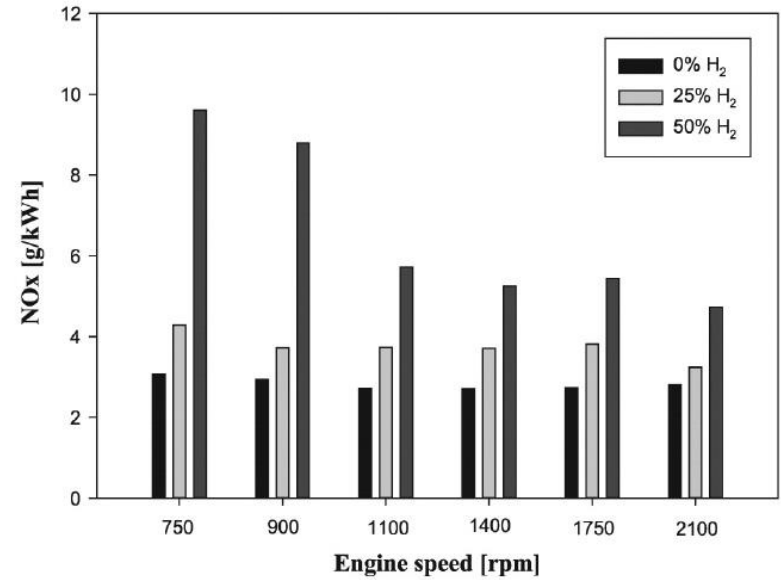
Figure 18. Increase of NO x emissions using hydrogen fuel in diesel engines [78].